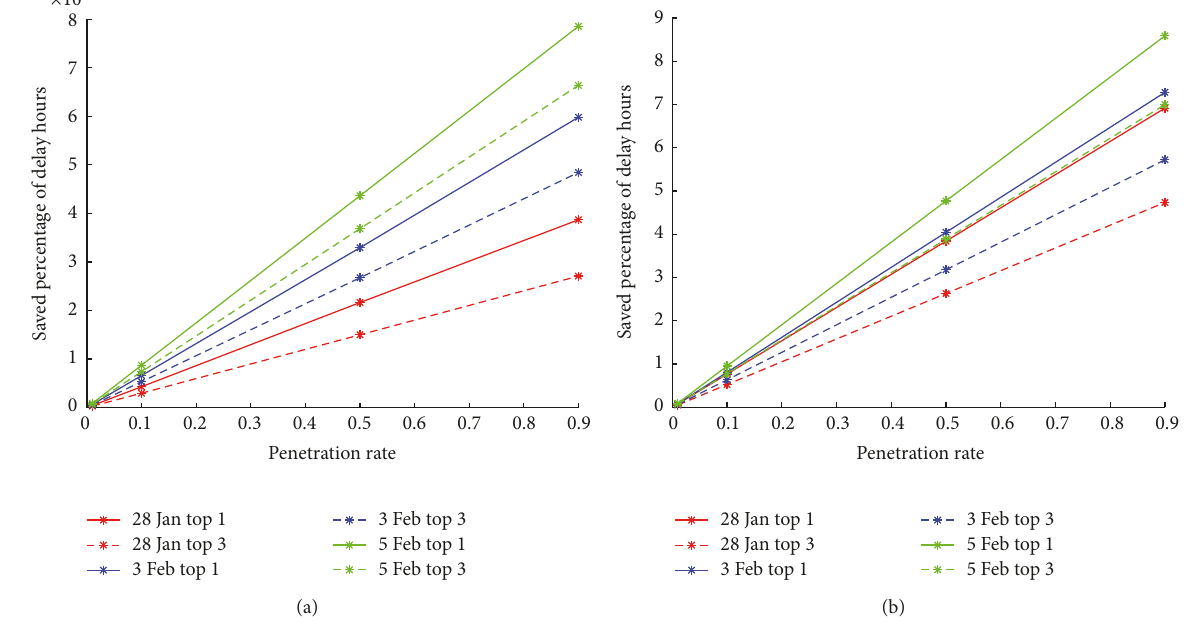
Figure 12: Saved delay hours as total over the whole day (a) and as a percentage with regard to the situation without routing advice (b). Table 2: Relation between penetration rate of FCD, speed error, and link availability. Penetration rate of